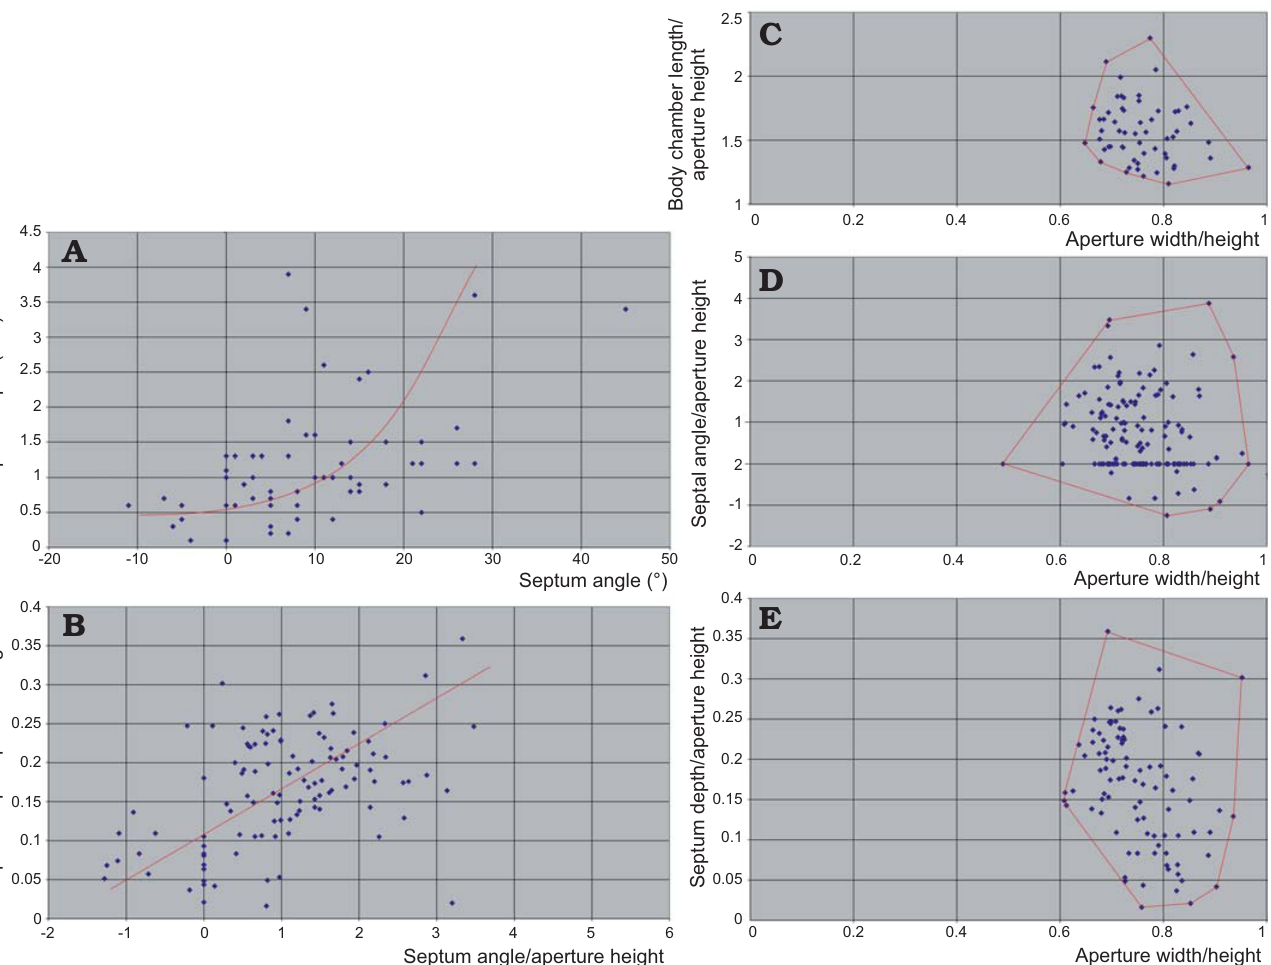
Fig. 12. Relationships between the basic conch geometry aspects of ellesmeroceratid nautiloids from sample Ang-4, block No. 1, probably latest Furongian